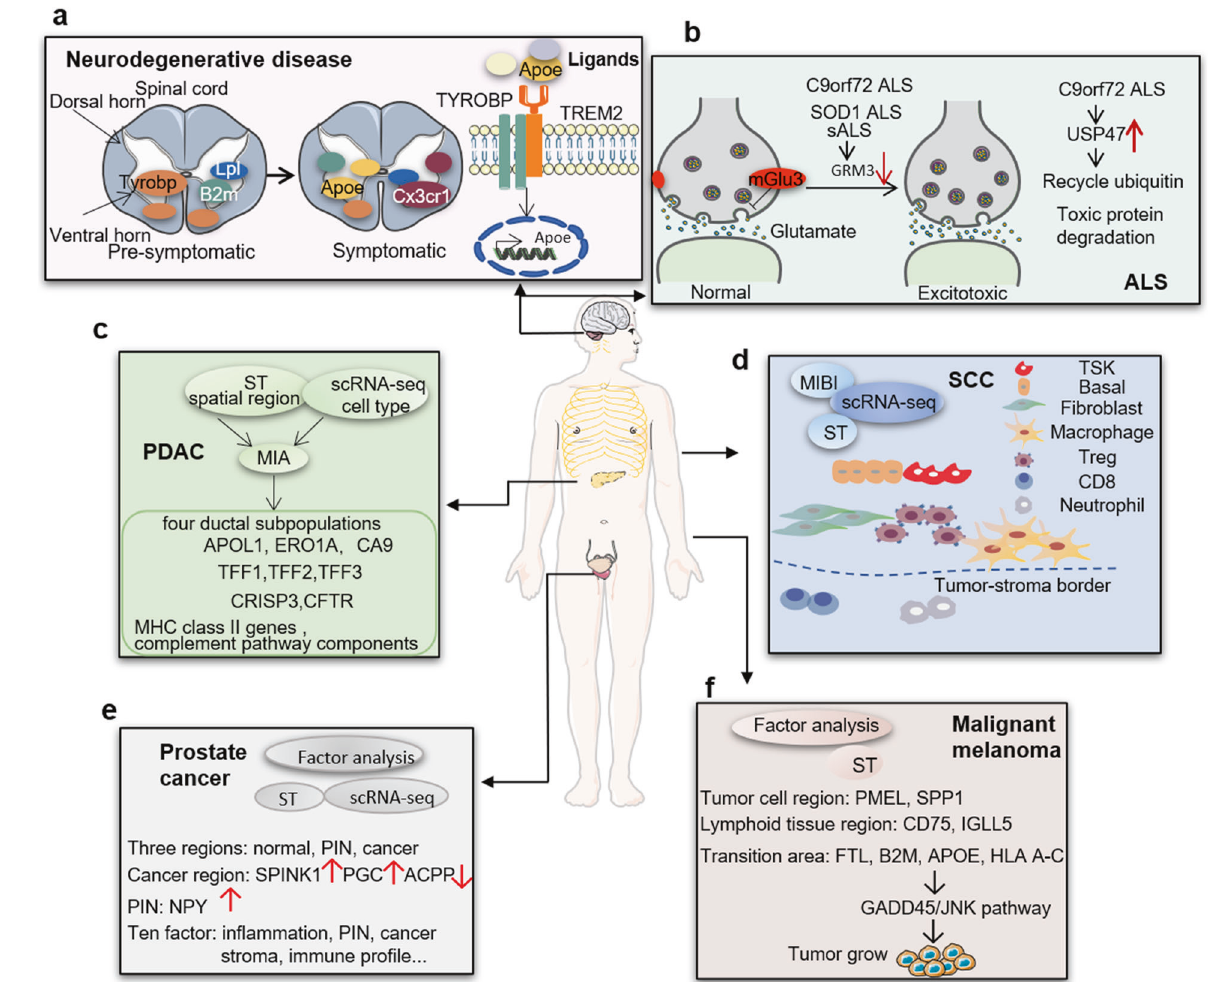
Fig. 4 Spatial transcriptomics provide new insights for understanding molecular mechanisms of human diseases and preclinical disease models. a In neurodegenerative disease models, Trem2 and Tyrobp form a receptor complex that can trigger phagocytosis or regulate cytokine signaling, when bound by membrane lipids or lipoprotein complexes. Tyrobp expression is up-regulated before symptoms and before Trem2 expression in the ventral horn and white matter. Lp1 and B2m are up-regulated before symptoms, especially in the ventral horn. Apoe and Cx3cr1 are up-regulated in the spinal cord of symptomatic mice. Apoe expression is driven by Trem2 signal and the ligand of Trem2. b In amyotrophic lateral sclerosis (ALS) models, expression of GRM3 gene in the prefrontal lobe and motor cortex was lower in C9orf72 repeat expansion, mutant SOD1 , and sALS. The GRM3 gene encodes mGlu3, a metabotropic glutamate receptor, regulates the neurotransmission of glutamate in the central nervous system. The expression of neuronal mGlu3 receptor is mainly at presynaptic terminals. When the extrasynaptic glutamate over fl ows excessively, the G protein signaling cascade is activated to regulate the activity of presynaptic ion channels, followed by negatively regulating the release of presynaptic glutamate. The regulation that the decrease of mGlu3 receptor expression in the prefrontal cortex increases the transmission of glutamate and produces excitotoxicity may be a common mechanism feature between schizophrenia and ALS. c Spatial positions of different subgroups are identi fi ed and mapped within cell type in the entire tissue by integrating scRNA-seq and MIA. A total of four ductal subgroups are identi fi ed, including ductal population, terminal ductal population, centroacinar duct population, and antigen-presenting duct cells, respectively expressing APOL1 , ERO1A and CA9 genes; TFF1 , TFF2 and TFF3 ; CRISP3 genes; CD74 , HLA -DPA1 , HLA-DQA2 , HLA-DRA , HLA-DRB1 and HLA-DRB5 , and C1S , C4A , C4B , CFB and CFH genes. d The combined application of spatial transcriptomics, scRNA-seq, and MIBI demonstrates that TSK cells and basal tumor cells are located on the leading edge. Fibroblasts, macrophages and Tregs are most abundant at the tumor-stroma boundary, while CD8 T cells and neutrophils are largely excluded from the tumor, indicating that the localization of Tregs may prevent effector lymphocytes into the tumor. e The gene expression in 3 regions obtained by factor analysis is applied for identifying region-speci fi c markers in normal, cancer and PIN region. Enrichment of SPINK1 and PGC , the depletion of ACPP , and the increase of NPY level in the PIN area are observed in cancer areas. In addition, the interaction between factors was determined by hierarchical clustering of ten factors. These ten factors include normal glands signature, normal glands, stroma, in fl ammation, PIN, cancer, immune pro fi le, proximity to PIN signature, and mix of prostatic atrophy and stroma et al. f In malignant melanoma models, PMEL and SPP1 overexpressed in tumor cell clusters, and the lymphoid tissue regions from and adjacent to tumor cell regions were characterized by the expression of immune-related genes CD74 and IGLL5 , respectively. FTL , B2M , APOE and HLA-related genes ( HLA A-C ) express in the transition zone and related to tumor growth regulation through the GADD45/JNK pathway identify therapeutic targets. ST pro fi les of periodontal tissues of the lymphoid area in close proximity to the tumor region was showed up-regulated expression of speci fi c polar shadow in the similar to that of tumor microenvironment. Spatial positioning of in fl ammatory area as part of pathogenesis of chronic in fl amma- transcriptomic pro fi les has great potential to help us understand tory periodontitis. 108 ST pro fi les of adult heart demonstrated molecular mechanisms of tumor progression, metastases, and to Signal Transduction and Targeted Therapy (2022)